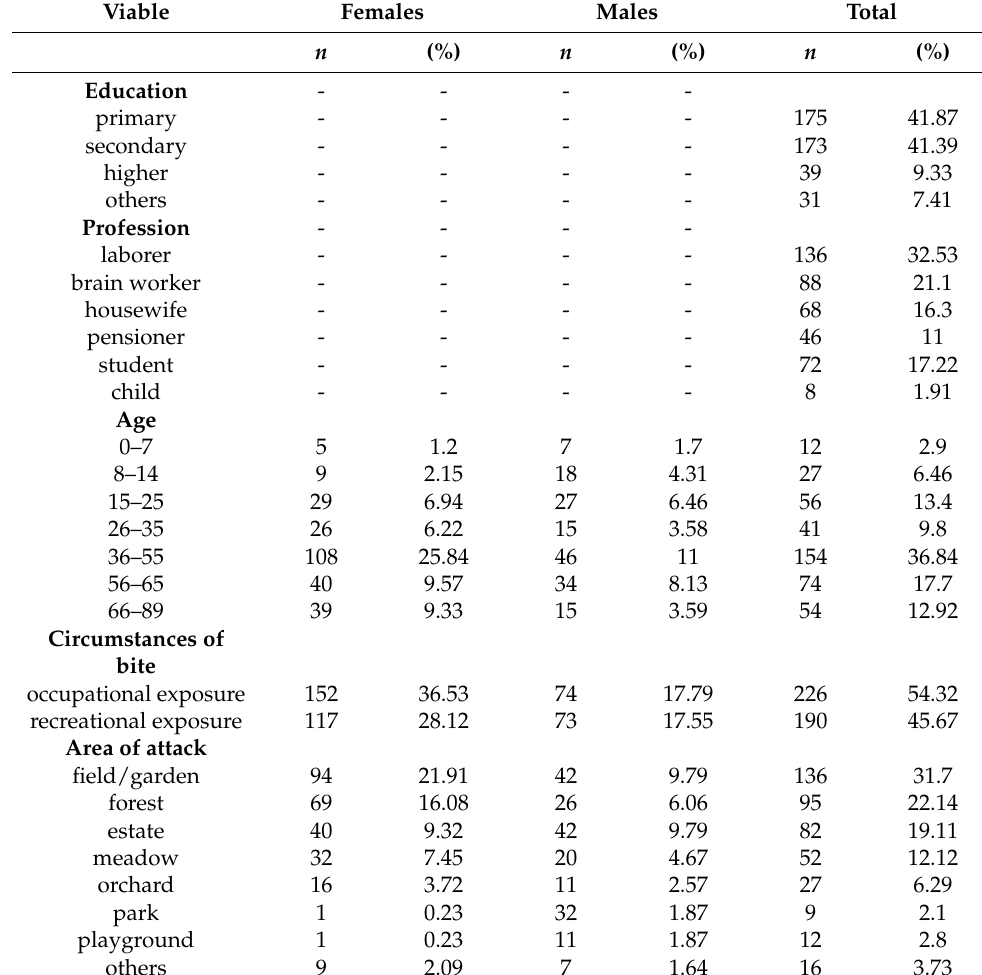
Table 1. Socioeconomic background and circumstances of black fly bites in studied patients from Lubelskie Province (southeastern Poland) (2003–2005, n =